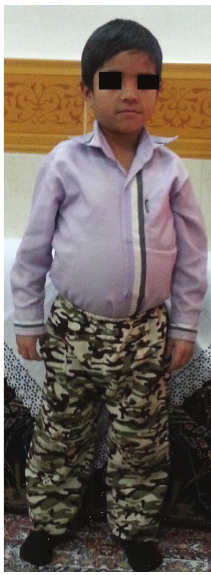
Figure 3: A nine-year-old boy with failure to thrive and abdominal distention.Notefacialdysmorphism(hypertelorismandbroadnasal